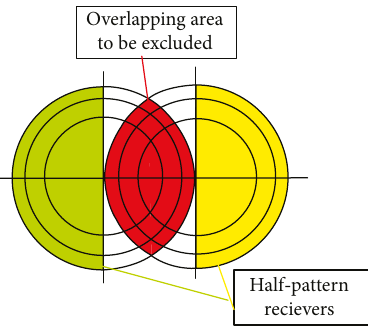
Figure 6: C alpha =3.1, 632.8nm.